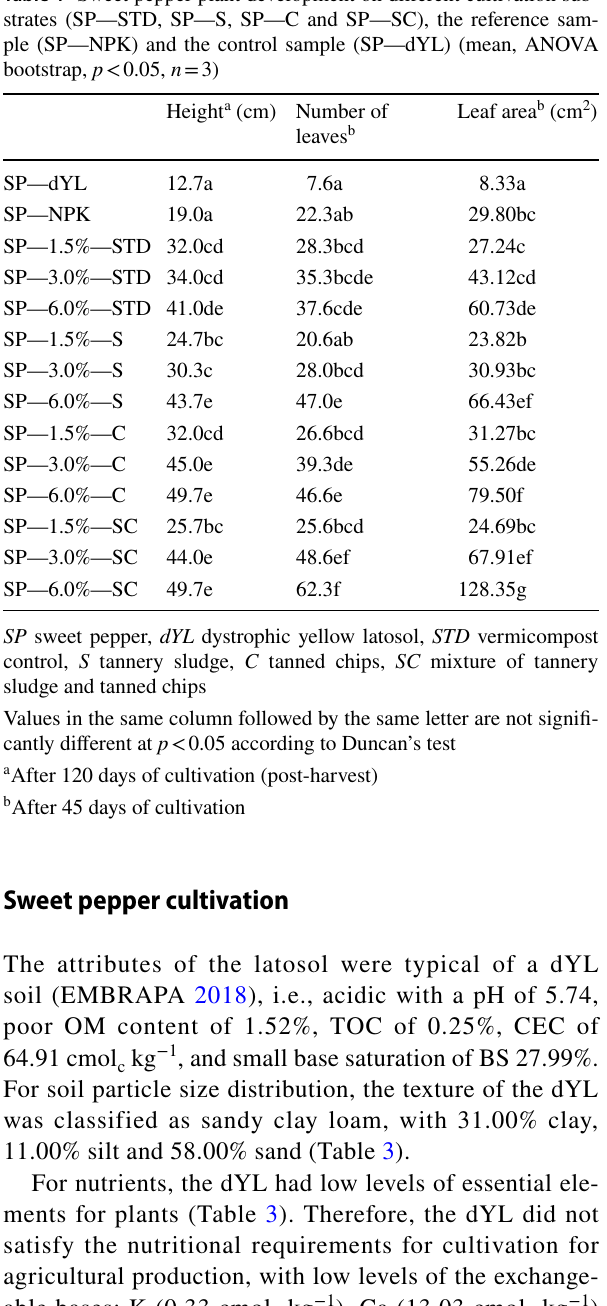
Table 4 Sweet pepper plant development on different cultivation